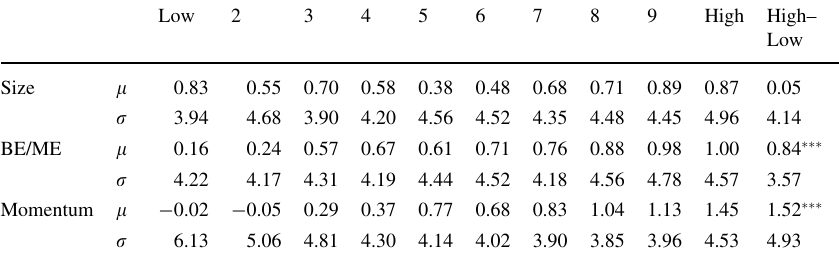
Table 3 Monthly averages and standard deviations of equal-weight portfolio returns from single sorts on